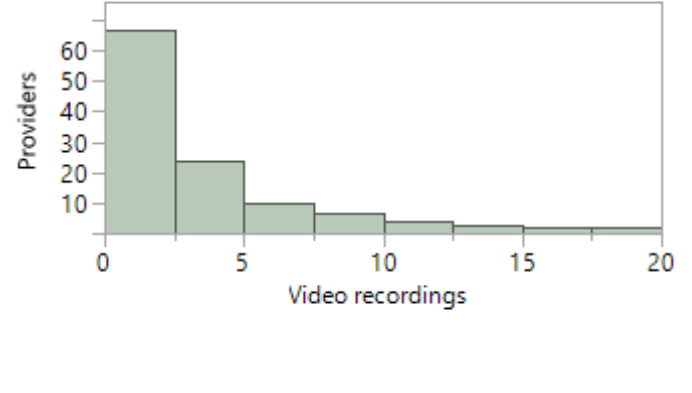
Figure 5. Distribution of provider experience level with videography. A single outlier who captured nearly 50 videorecordings is not included on the